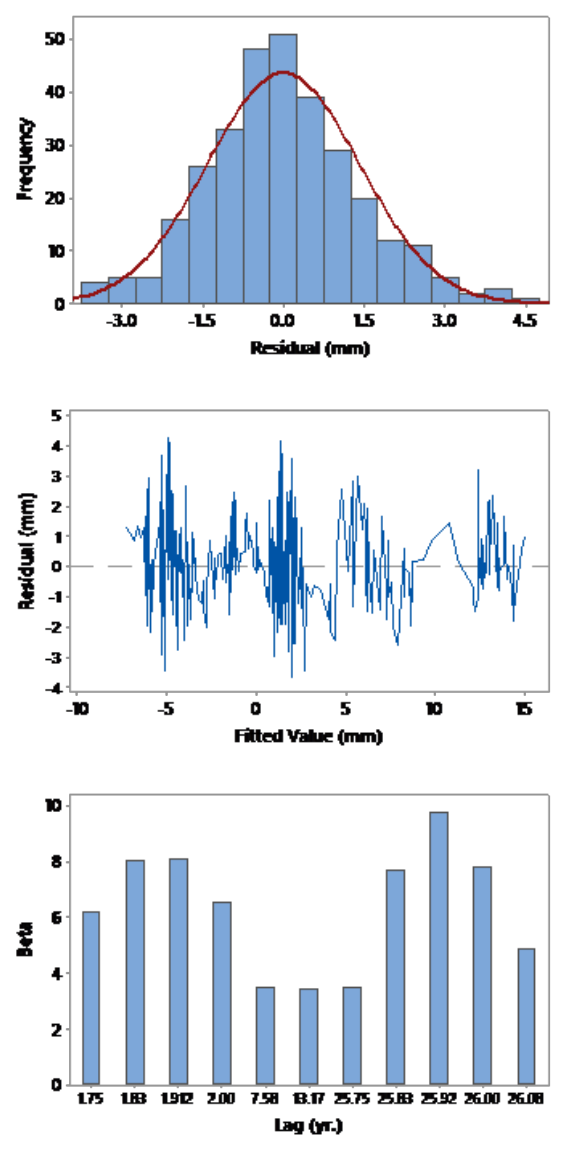
Fig. 4. Residuals of the mixed kinematic model solution now exhibit visually perceptible shocks/innovations (in red). Beta lag-weights are statistically significant at α = 0.05